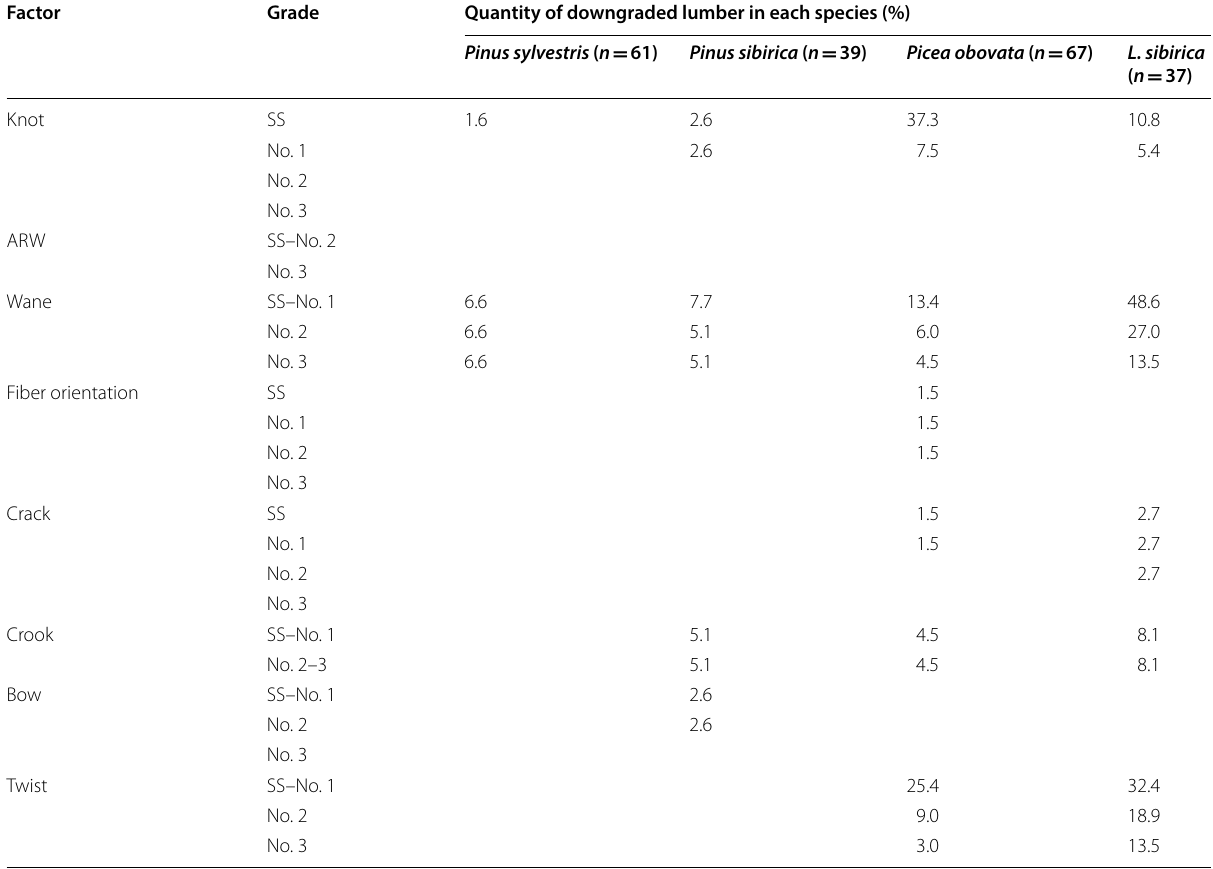
n , number of lumber; ARW, annual ring width; SS, select structural. The value was calculated from the ratio of the lumber downgraded to total lumber number in each species. When the threshold values of the JAS for structural lumber and finger jointed structural lumber for wood frame construction [25] are the same in several visual grading classes in a factor, the classes were combined Table 6 Mean values of lumber properties in each wood type in four species